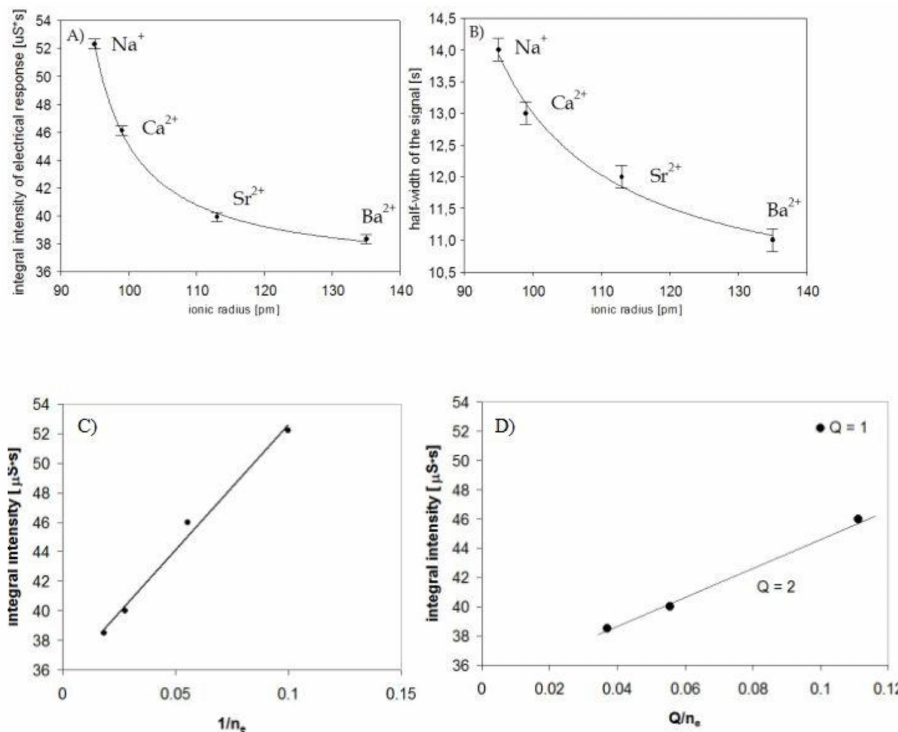
Figure 5. Changes in the signal parameters of the sensor due to the size of the ionic radius of the cations: ( A ) the integral intensity of the electrical response, ( B ) the half-width of the signal, ( C ) the integral intensity of the signals measured for all examined ions versus 1/n e , ( D ) the integral intensity of the signals measured for all examined ions versus Q/n e , where n e is the number of electrons (n e = Z-Q), Z is the atomic number of a metal and Q is the charge of a metal ion (in our case, Q = +1 or +2, for mono- and divalent ions,